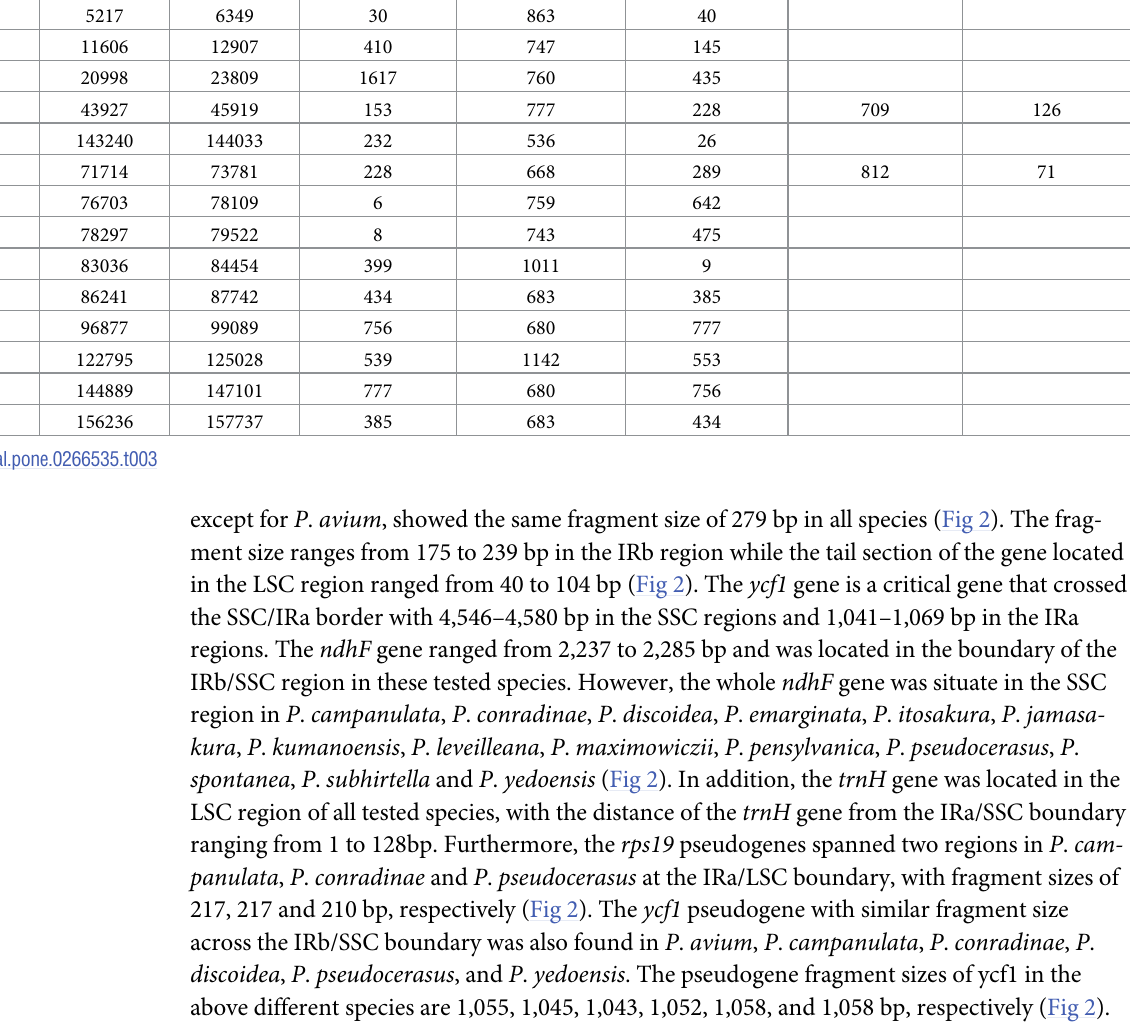
Table 3. Information on 10 intron-containing genes in the plastome of the 20 subg. Cerasus species studied. Gene